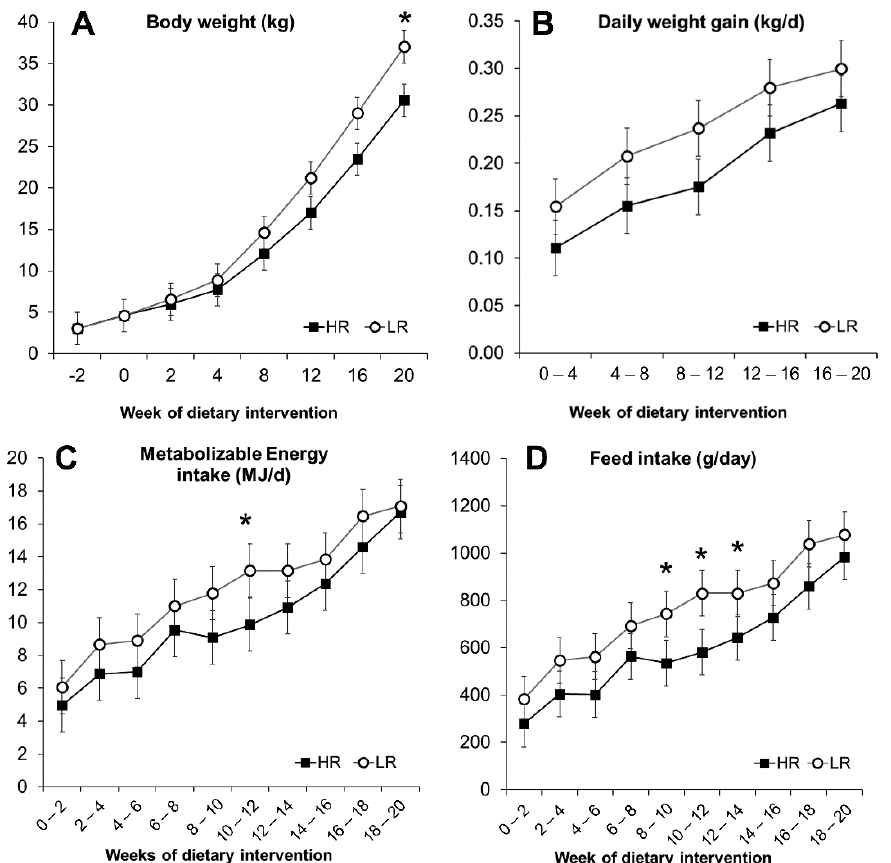
Figure 1. Development parameters of Göttingen Minipigs fed ad libitum a high-risk (HR, n = 15) and a lower-risk (LR, n = 15) diet. Body weight ( A ), daily weight gain ( B ), calculated metabolizable energy intake ( C ), and daily feed intake ( D ). Results are expressed as LS means, error bars indicating SEM. Significant difference (* p < 0.05). Table 2. Average nutrient intake over a 20-week intervention period and relative energy contribu- tion of diet components.